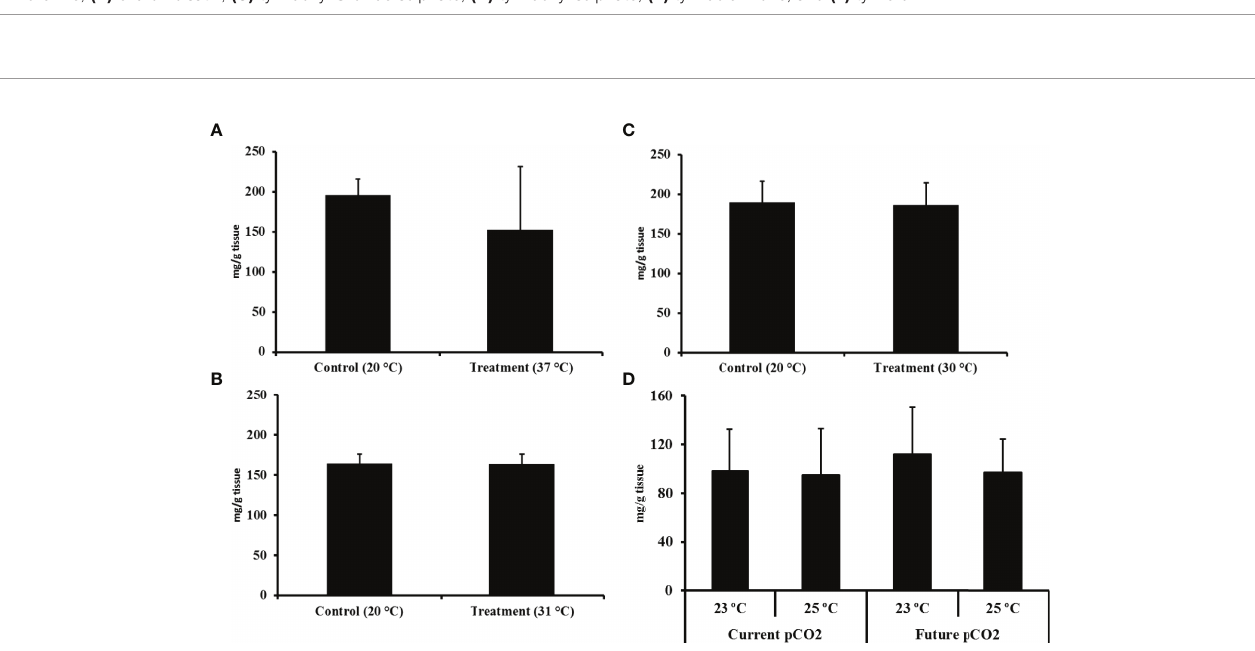
FIGURE 4 | Total yield in mg/g (mean % ± SD) of the ethanol extracts from the hypobranchial gland of Dicathais orbita : (A) Critical thermal maxima (CTMax) short- term, fast warming rate; (B) CTMax long-term, slow warming rate; (C) 7 day static heat stress; and (D) the 35 day ocean climate change